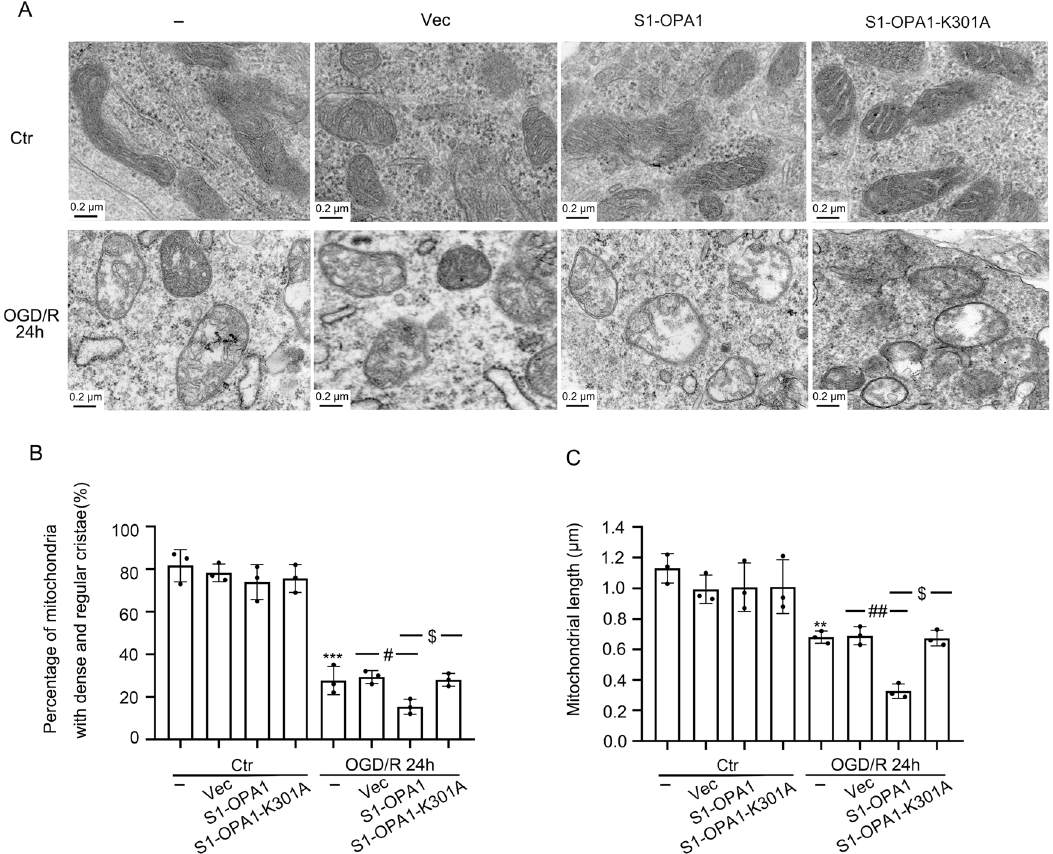
Fig. 3 S1-OPA1 overexpression impaired the morphology of mitochondrial cristae and mitochondrial length after OGD/R. A Representative transmission electron microscopy images of neuronal mitochondria. Mitochondria in the control group had dense cristae and appropriate mitochondrial length, but after OGD/R for 24 h, the cristae were damaged, mitochondrial edema appeared, and the length was shortened. B Fifty mitochondria were selected from each group to assess the proportion of mitochondria with fi ne and dense cristae. C Fifty mitochondria were selected from each group to assess mitochondrial length. *** p < 0.001 vs. control group, ** p < 0.01 vs. control group, ## p < 0.01, # p < 0.05, $ p < 0.05; scale bar = 0.2 μ m; n =